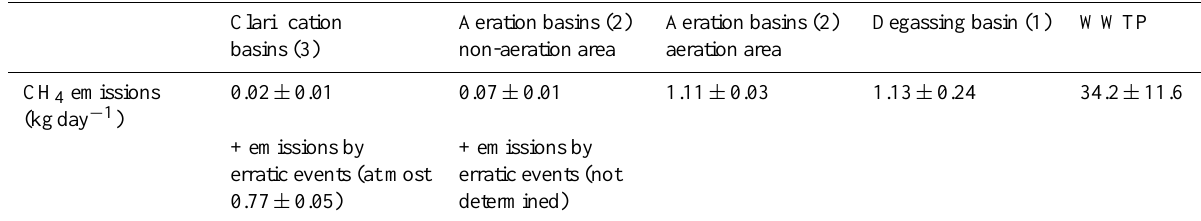
Table 5. Summary of the results from the process to the site scale. The given uncertainties were determined in different ways. Refer to the main text for details.